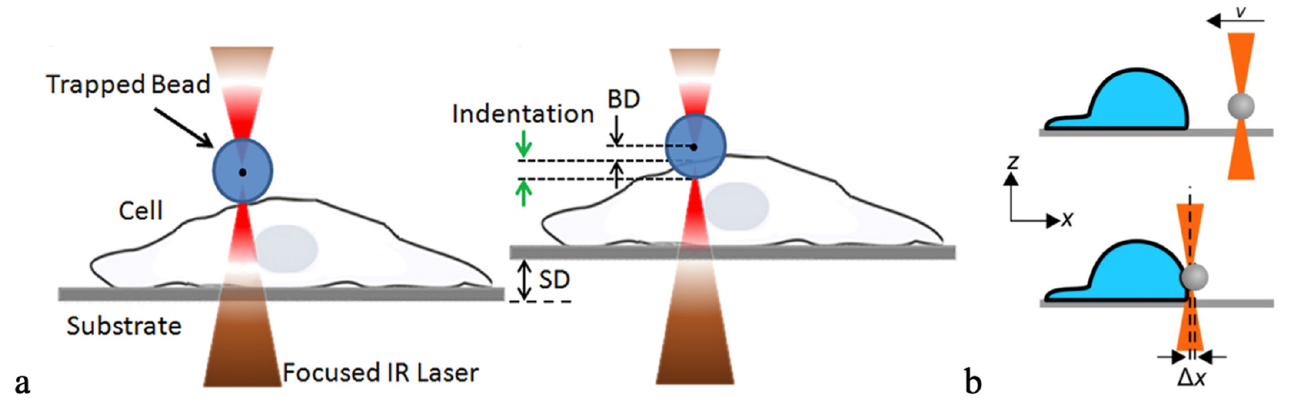
Figure 3. ( a ) conventional indentation assay: A cell is vertically manipulated into an optically trapped bead. The displacement of the optically trapped bead provides force measurements [26]. ( b ) lateral indentation assay: A cell is static, while an optically manipulated bead is laterally in- dented into the cell